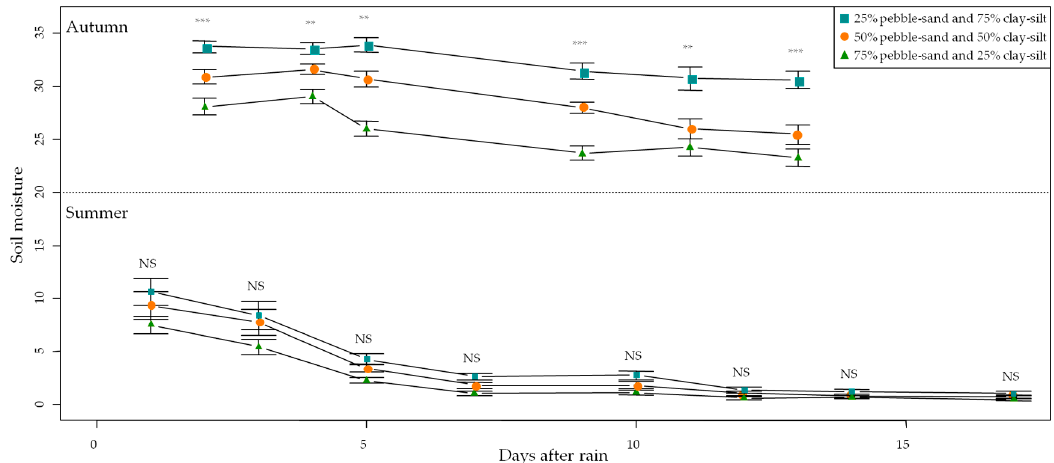
Figure 5. Evolution of substrate moisture according to substrate composition on the roof of Avignon IUT (Southeastern France) in summer and autumn 2016. Values are means of substrate moisture ± standard errors for each substrate composition and for each survey period. The stars represent significant differences between the three substrate compositions for a survey date, NS: not significant from the post hoc test of Tukey HSD (Honest Significant Difference).